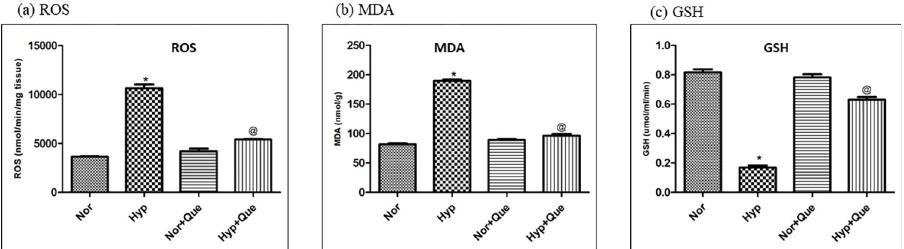
Fig 8. Effect of quercetin supplementation (50mg/Kg BW) in kidneys of rats exposed to 7,620m for 12h at 25 ± 2˚c (a) Reactive Oxygen Species (ROS) (b) Malondialdehyde (MDA) and (c) Reduced Glutathione (GSH) generation in kidneys of rats exposed to hypobaric hypoxia at 7,620m for 12h at 25 ± 2˚C. � p < 0.001 Norm v/s Hypo 12h; @ p < 0.001 Hypo v/s Hypo+ Que. Values are mean ± SD (n = 6). Norm-Normoxia control, Hypo–Hypobaric Hypoxia (12h); Que- Quercetin (50mg/kg BW).